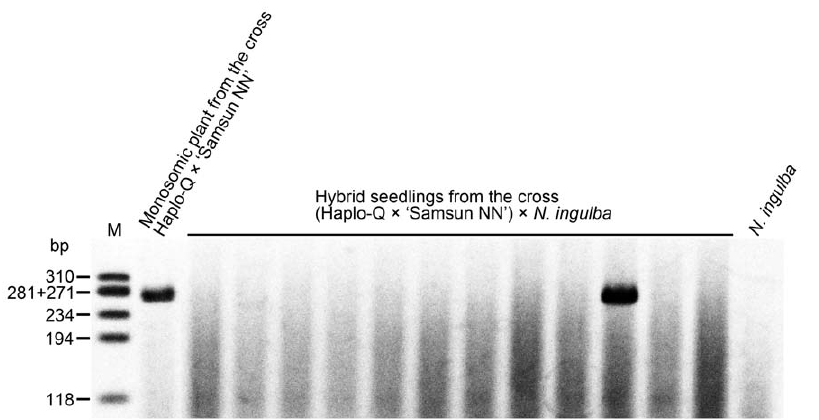
Figure 3. Detection of the SSR marker PT1348 in hybrid seedlings from the cross (Haplo-Q 6 ‘Samsun NN’) 6 N.ingulba . PT1348 was detected in one hybrid seedling but not in the other 11 hybrid seedlings. M, size marker w X174/ Hae III.